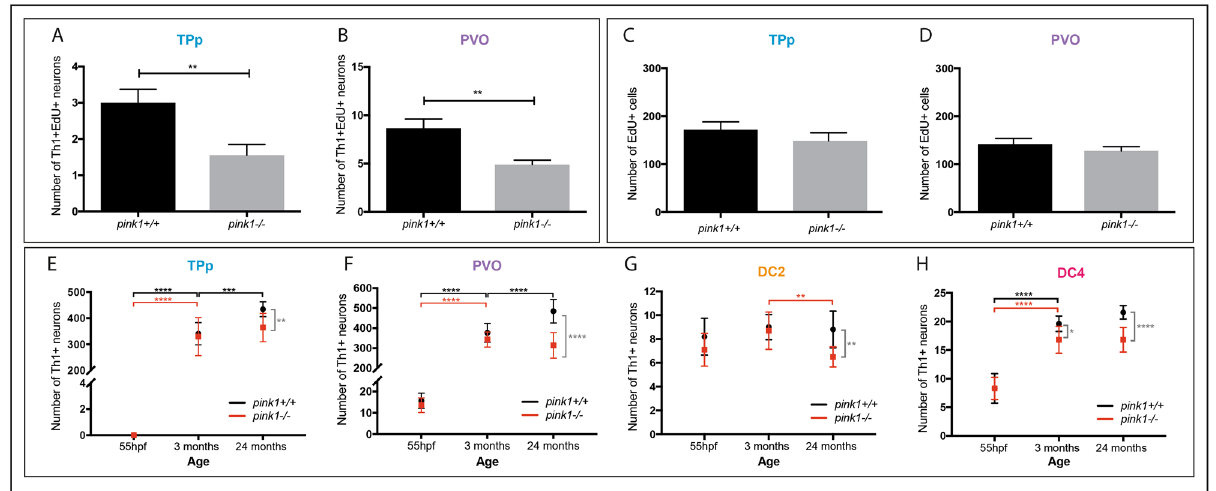
Figure 5. Adult generation of DA neurons is impeded in pink1 -/- zebrafish. (A,B) Quantification of the number of newly generated Th1 + EdU + DA neurons in pink1 +/+ and pink1 -/- zebrafish shows a significant reduction in the TPp (A) ( t -test, p = 0.0078, n = 9 for each) and in the PVO (B) ( t- test, p = 0.0017, n = 9 fish for each) of 3 month pink1 -/- zebrafish compared to pink1 + / + siblings. ( C,D ) No difference in the total number of EdU + cells in the TPp (C) ( t -test, p = 0.3431, n = 9 fish for each) and in the PVO (D) ( t -test, p = 0.3640, n = 9 fish for each) in 3 month pink1 -/- zebrafish compared to pink1 +/+ siblings. ( E ) Quantification of DA neurons in the TPp shows an increase in the number of DA neurons in pink1 +/+ zebrafish (black line) between 55hpf and 3 months (two- way ANOVA, p = < 0.001, n = 10 fish for each) and between 3- and 24 months (two-way ANOVA, p = 0.0001, n = 10 fish for each). In pink1 -/- zebrafish, the number of DA neurons increases between 55hpf and 3 months (two-way ANOVA, p = < 0.001, n = 10 fish for each), but not between 3- and 24 months (two-way ANOVA, p = 0.4587, n = 10 fish for each). pink1 -/- zebrafish (red line) have significantly fewer DA neurons in the TPp at 24 months (two-way ANOVA, p = 0.0065, n = 10 fish for each) but not at 55hpf (two-way ANOVA, p = > 0.9999, n = 10 fish for each) or at 3 months (two-way ANOVA, p = 0.9917, n = 10 fish for each). ( F ) Quantification of DA neurons in the PVO shows in pink1 +/+ zebrafish (black line), the number of DA neurons significantly increases between 55hpf and 3 months (two-way ANOVA, p = < 0.0001, n = 10 fish for each) and between 3 and 24 months (two-way ANOVA, p = < 0.0001, n = 10 fish for each). In pink1 -/- zebrafish (red line), the number of DA neurons significantly increases between 55hpf and 3 months (two-way ANOVA, p = < 0.0001, n = 10 fish for each) but not between 3 and 24 months. pink1 -/- zebrafish have significantly fewer DA neurons than pink1 +/+ zebrafish in the PVO at 24 months of age (two-way ANOVA, p = < 0.0001, n = 10 fish for each) ( G ) Quantification of DA neurons in the DC2 population shows pink1 +/+ zebrafish (black line), the number of DA neurons does not significantly increase between 55hpf and 3 months, or between 3 and 24 months. In pink1 -/- zebrafish (red line), the number of DA neurons does not significantly increase between 55hpf and 3 months, but significantly decreases between 3 and 24 months (two-way ANOVA, p = 0.0077, n = 10 fish for each). pink1 -/- zebrafish have significantly fewer DA neurons than pink1 + / + zebrafish in the TPp at 2-years of age (two-way ANOVA, p = 0.0065, n = 10 fish for each). ( H ) Quantification of DA neurons in the DC4 population shows in pink1 +/+ zebrafish (black line), the number of DA neurons significantly increases between 55hpf and 3 months (two-way ANOVA, p = < 0.0001, n = 10 fish for each) but not between 3 and 24 months. In pink1 -/- zebrafish (red line), the number of DA neurons significantly increases between 55hpf and 3 months (two-way ANOVA, p = < 0.0001, n = 10 fish for each) but not between 3 and 24 months. pink1 -/- zebrafish have significantly fewer DA neurons than pink1 +/+ zebrafish in the PVO at 3 months (two-way ANOVA, p = 0.0308, n = 10 fish for each) and even more so at 24 months of age (two-way ANOVA, p = < 0.0001, n = 10 fish for